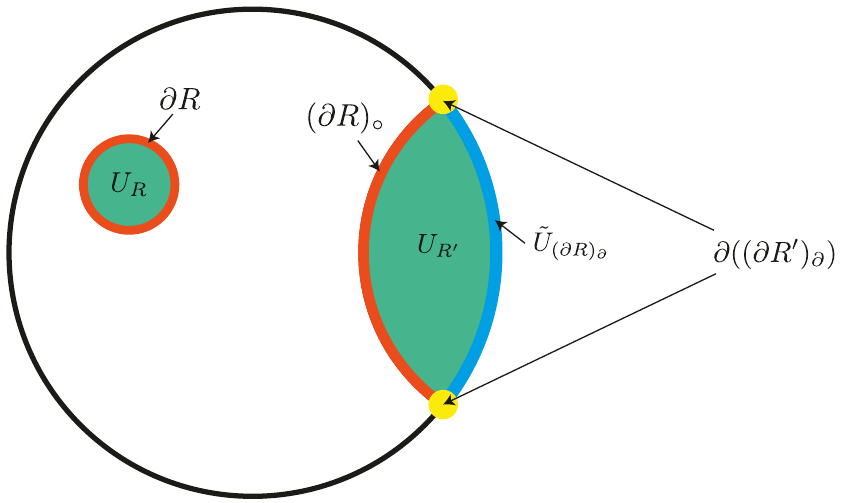
Figure 13. The symmetry action U R within a Bulk region R introduces a domain wall along a neighborhood of its boundary. A symmetry action U in a Bulk region R 0 along with a Boundary R 0 symmetry action ˜ U where R 0 coincides with the Boundary introduces a domain wall along a ( ∂R ) ∂ neighborhood of the boundary ( ∂R 0 ) and a Bulk defect (or Boundary domain wall) in a neighbor- ◦ hood of ∂ (( ∂R 0 ) ) ∂